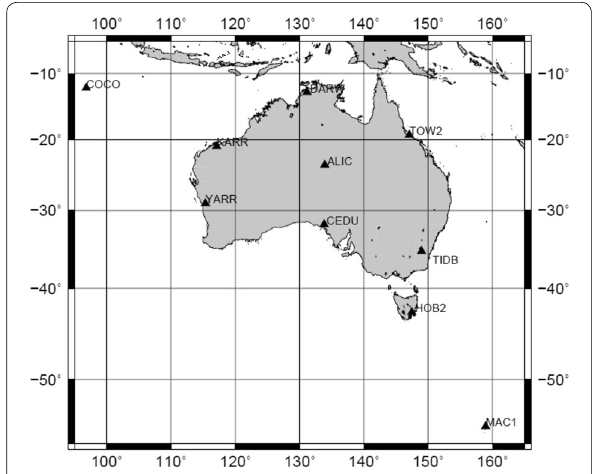
Fig. 1 AFN stations across the Australian plate with RVS in 1998, including seven mainland Australia stations, one Tasmanian station and two stations on Macquarie and Cocos Islands